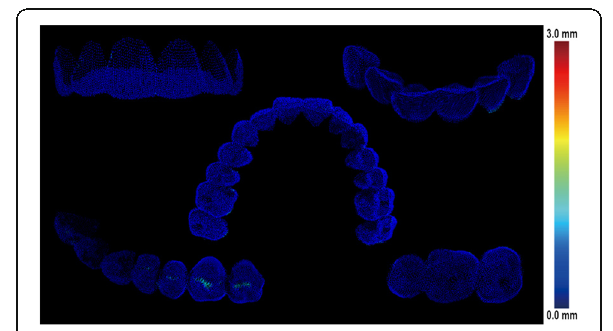
Fig. 11 Color map of the superimposed 3D dataset of the imposter